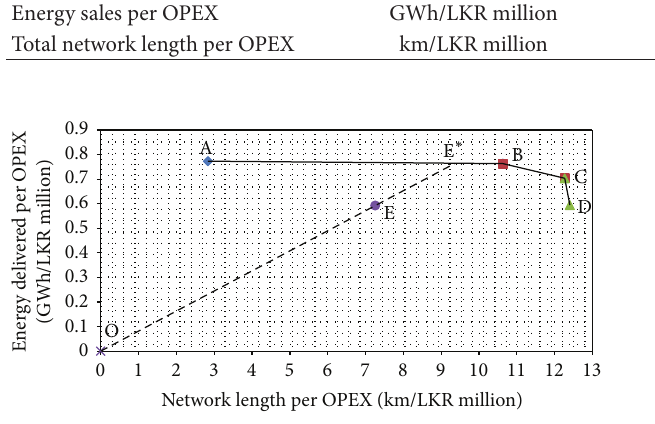
Figure 3: Graphical representation of DEA implementation.